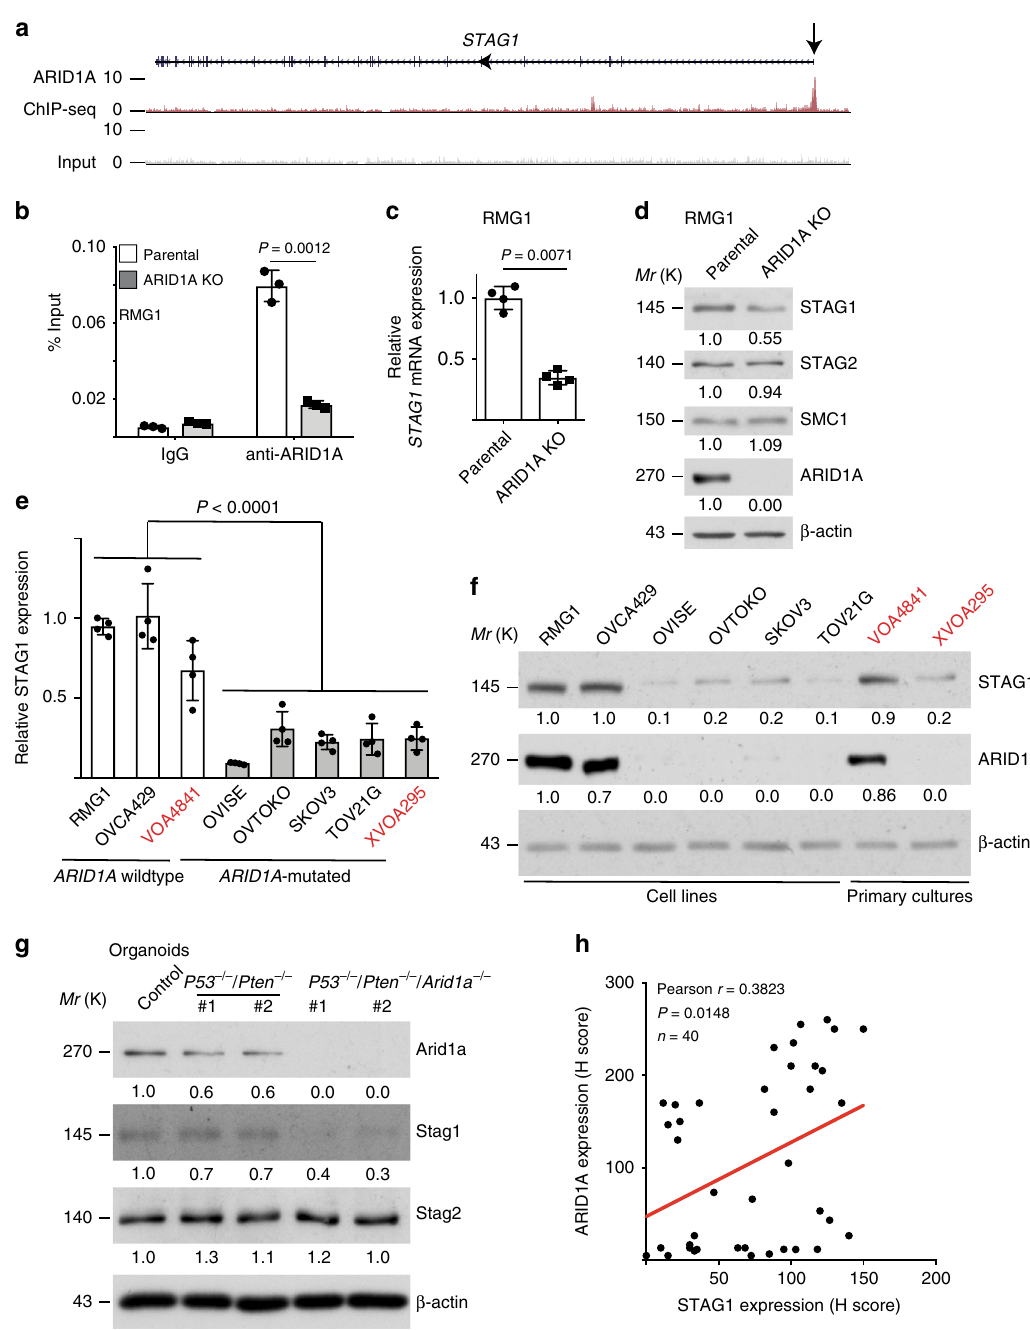
Fig. 4 ARID1A promotes STAG1 expression. a ARID1A ChIP-seq and input tracks of the STAG1 gene locus in RMG1 cells. b Validation of ARID1A binding to the STAG1 promoter by ChIP-qPCR in parental and ARID1A knockout RMG1 cells. c , d Validation of STAG1 downregulation by ARID1A knockout at the mRNA levels determined by qRT-PCR analysis ( c ) and at the protein levels determined by immunoblot ( d ) in RMG1 cells. Expression of other cohesin subunits STAG2 and SMC1 was used negative controls. e , f Expression of STAG1 at the mRNA levels determined by qRT-PCR analysis ( e ) and at the protein levels by immunoblot ( f ) in the indicated clear cell ovarian cancer cell lines or primary cultures highlighted in red. g Immunoblot of cohesin subunits Stag1 and Stag2 in wild-type controls, P53 − / − / Pten − / − and P53 − / − / Pten − / − /Arid1a − / − mouse bladder organoid cultures. h Correlation analysis between the expression of ARID1A and STAG1 in tumor microarray (TMA) of clear cell ovarian carcinomas determined by immunohistochemical staining. n = 3 independent experiments unless otherwise stated. Data represent mean ± s.e.m. P values were calculated using a two-tailed t test except for 4e by multilevel mixed-effects models, and for 4 h by Pearson correlation analysis. Relative intensities of immunoblot bands were quanti fi ed